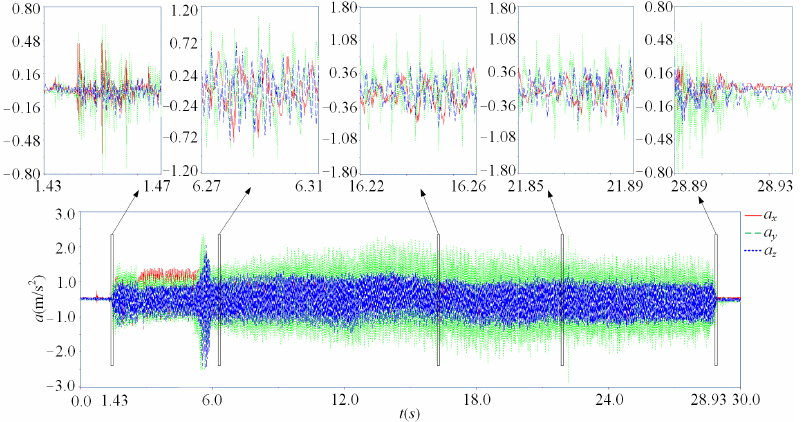
Figure 19. The milling vibration acceleration signal (scheme 2).